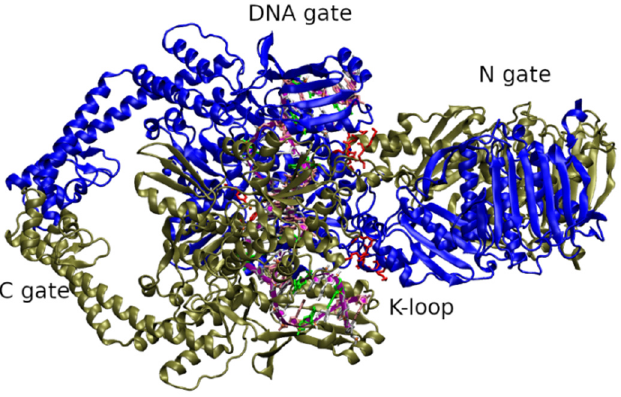
Figure 2. ScTopo II (PDBID: 4GFH) domain organization, three major gates: N-gate, DNA gate and C-gate. Each of the dimer is represented in either blue color or gray color for distinction (a). A strand of DNA, G-segment, is bound at the DNA binding gate (represented in purple ribbon), (b) A consensus K-loop in red licorice representation.